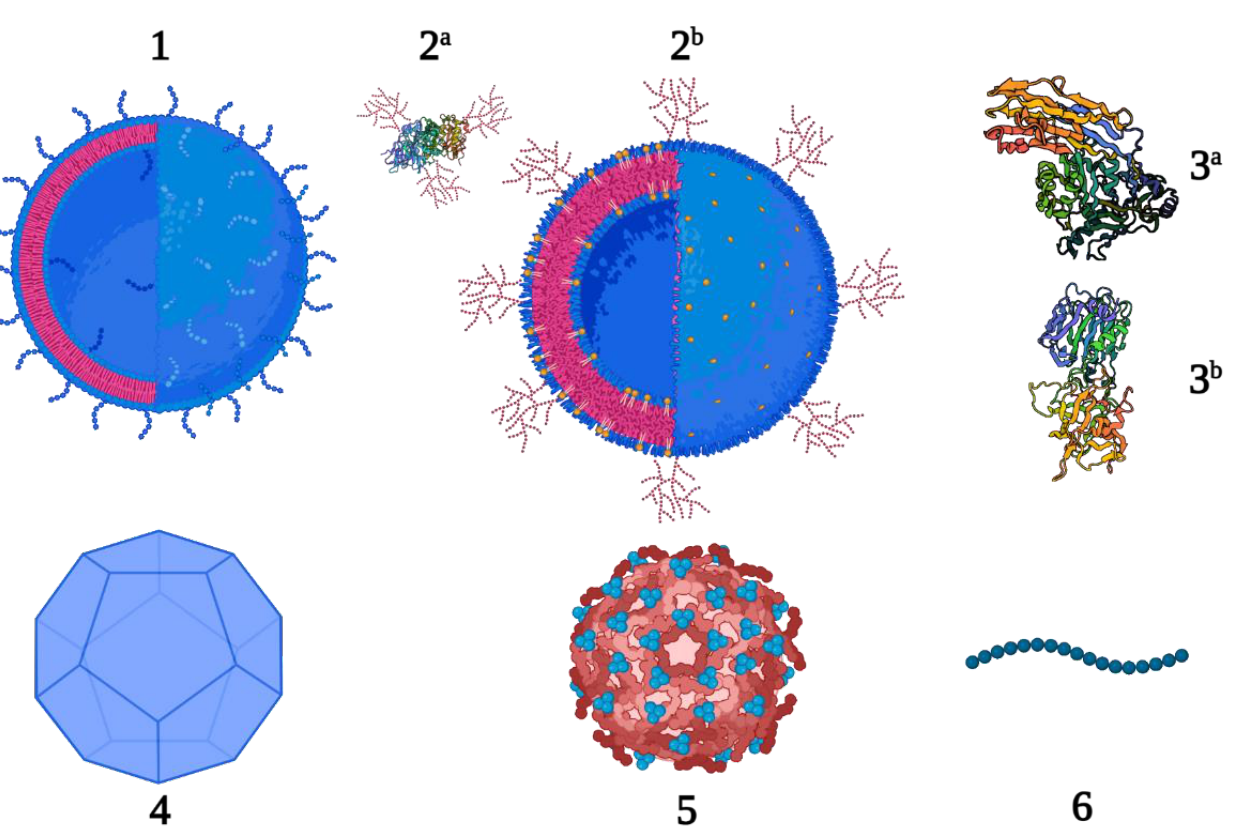
Figure 1. New carrier proteins for conjugate vaccines; OMV and GMMA ( 1 ), glycoengineered proteins ( 2 a P. aeruginosa exotoxin A, PDB 1IKQ) and OMV ( 2 b ), proteins ( 3 a Streptococcus pyogenes streptolysin O, PDB 4HSC and 3 b receptor-binding fragment HC of tetanus neurotoxin, PDB 1AF9), VLP ( 4 ), protein nanocages ( 5 ) and peptides ( 6 ).